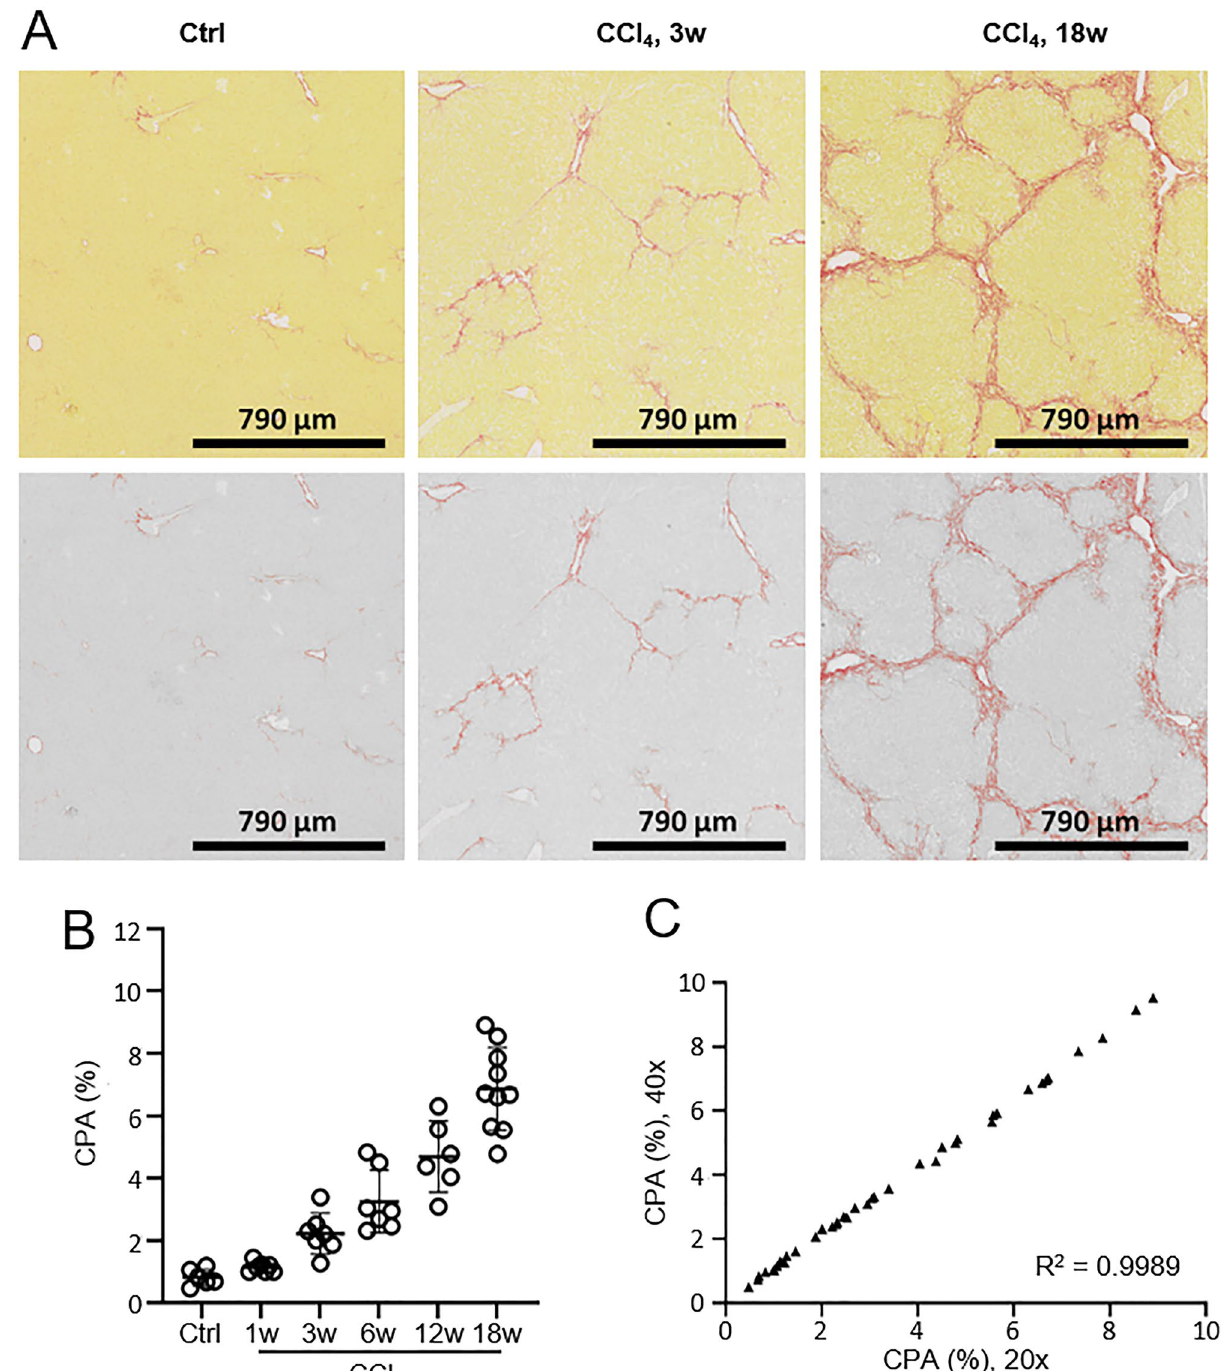
Figure 1. ( A ) Representative images of liver sections from CCl4-treated mice at weeks 0 (Ctrl), 3 (3w) and 18 (18w); the upper panel corresponds to native images of picrosirius red-stained liver sections, the bottom panel shows the corresponding digital images, obtained with MorphoQuant software, in which collagen fibers were pseudocolored in red and liver tissue in grey. (B) Evolution of collagen proportionate area (CPA%) relative to the selected timepoints. ( C ) Correlation of CPA values obtained in the same picrosirius red-stained sections at 20 × and 40 × respectively using MorphoQuant software. Results were expressed as mean value ± SD (n = 3 sections/mouse, 6–10 mice/group). R 2 : coefficient of determination. p value < 0.05 was considered statistically